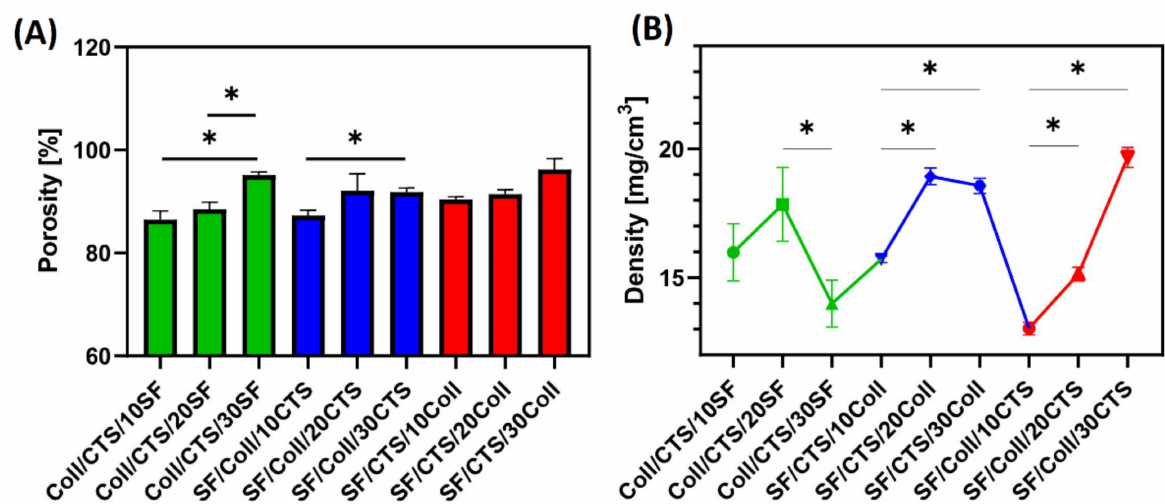
Figure 11. Results of ( A ) porosity and ( B ) density measurements of biopolymeric three-component scaffolds cross-linked by EDC/NHS; *—represents statistically significant differences between samples ( p ≤